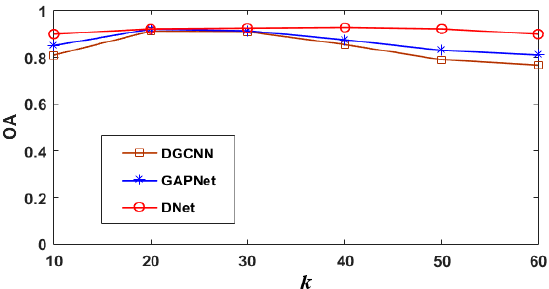
Figure 9. The influence of the number of initial neighborhood points on classification accuracy.